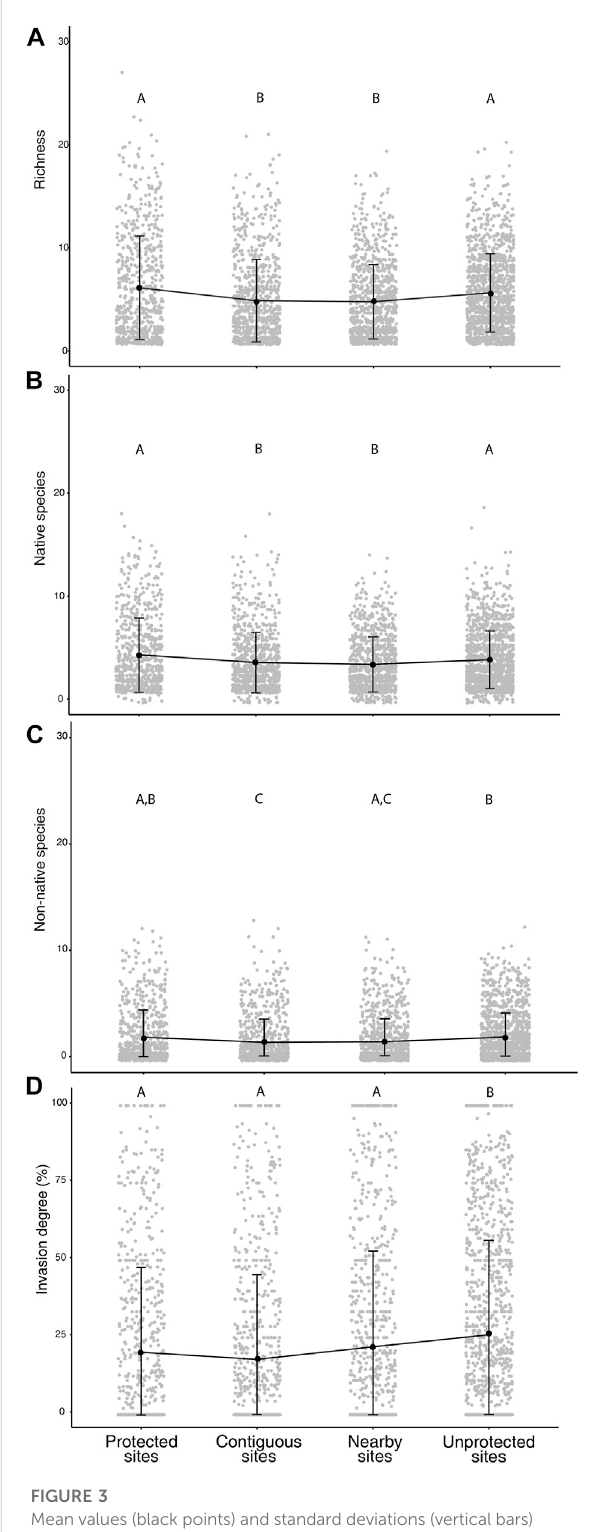
FIGURE 2 Mean values (black points) and standard deviations (vertical bars) of human footprint (A) , river fragmentation index (B) , LIM (C) and animal farming density (D) for Protected, Contiguous, Nearby, and Unprotected sites. Capital letters show the results of the Dunn ’ s test, with sites having different letters indicating signi fi cant difference ( p < 0.05).